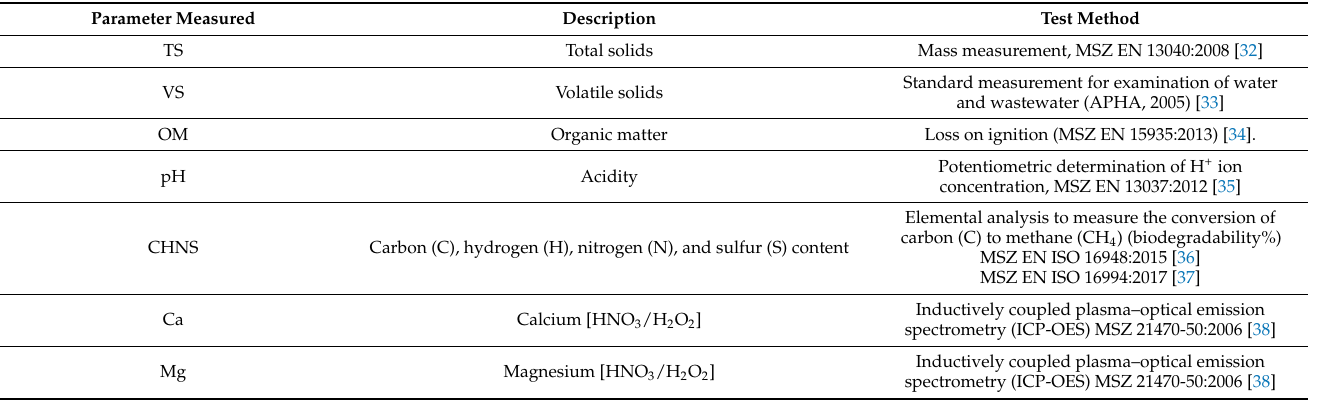
Table 2. Measured physicochemical parameters during the